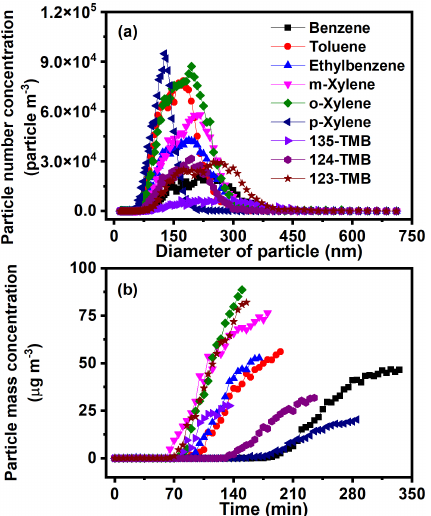
Figure 5. (a) Number concentration and (b) mass concentration of SOA produced from AH photochemical oxidation with the pres- ence of NO x (2000ppb of benzene and 160.2ppb of NO x , 1048ppb of toluene and 162.0ppb of NO x , 1050ppb of ethylbenzene and 162.4ppb of NO x , 889ppb of m -xylene and 172.1ppb of NO x , 1052ppb of o -xylene and 159.8ppb of NO x , 1040ppb of p -xylene and 157.2ppb of NO x , 956ppb of 123-TMB and 171.4ppb of NO x , 1010ppb of 124-TMB and 169.5ppb of NO x , 1040ppb of 135- TMB and 164.2ppb of NO x ).